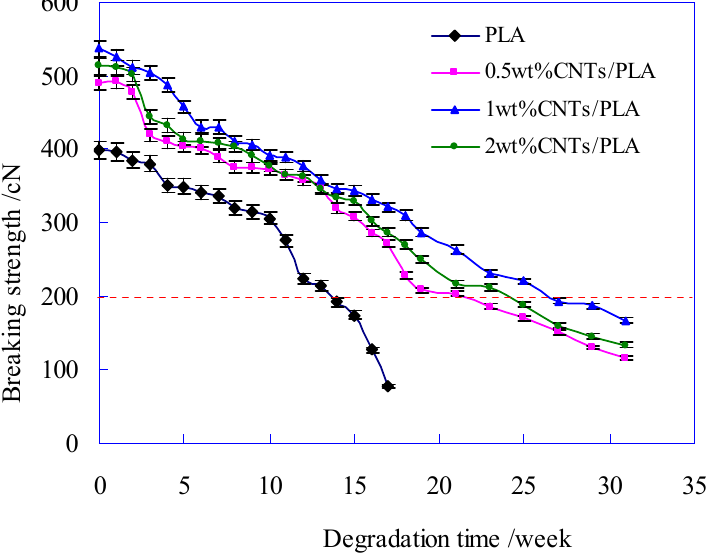
Figure 7. Breaking strength of pure PLA suture and CNTs / PLA sutures during degradation.